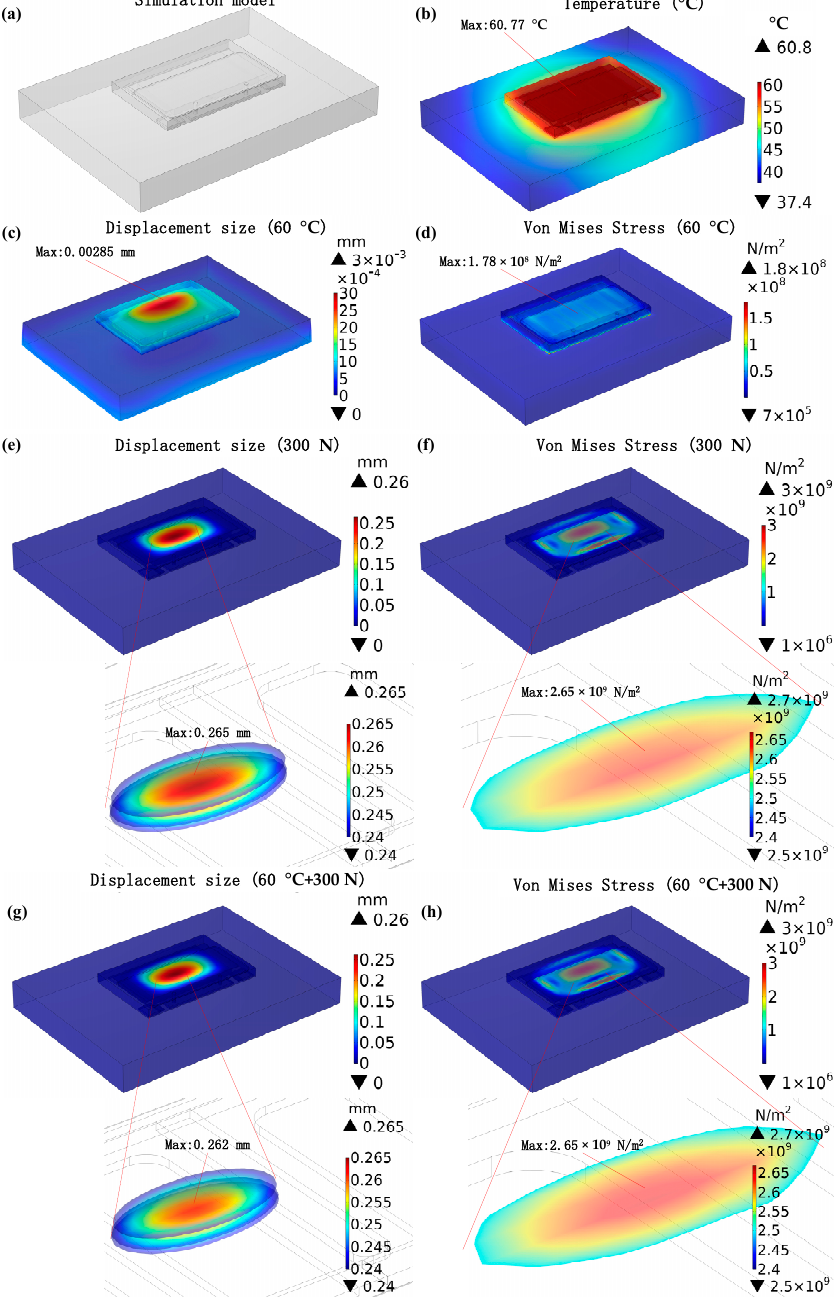
Figure 11. Experimental simulation model ( a ), temperature distribution ( b ), displacement size ( c ), and von Mises stress distribution ( d ) after electro-thermal coupling stress of 60 °C; displacement size ( e ) and von Mises stress distribution ( f ) after mechanical planar stress of 300 N; displacement size ( g ) and von Mises stress distribution ( h ) after electro-thermo-mechanical coupling stress.